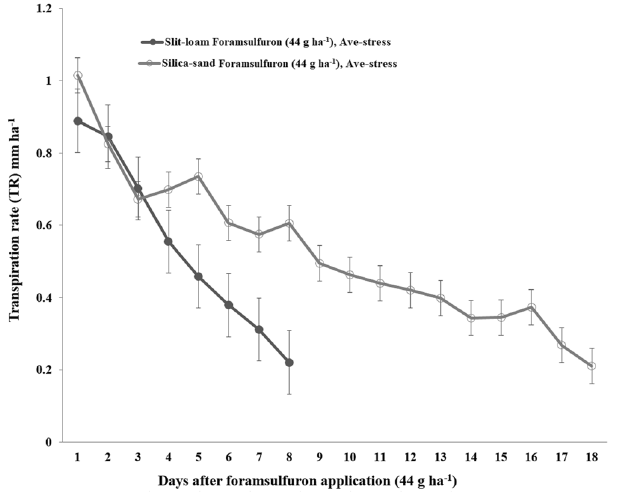
Figure 2. Transpiration rate (TR) data collected after treating three-tiller goosegrass [ Eleusine indica (L) Gaertn] with foramsulfuron (0 or 44 g ha −1 ) in progressive soil drying experiments conducted in a greenhouse located at the West Tennessee AgResearch and Education Center (Jackson, TN) during 2019. Error bars represent standard error of the mean on each date.